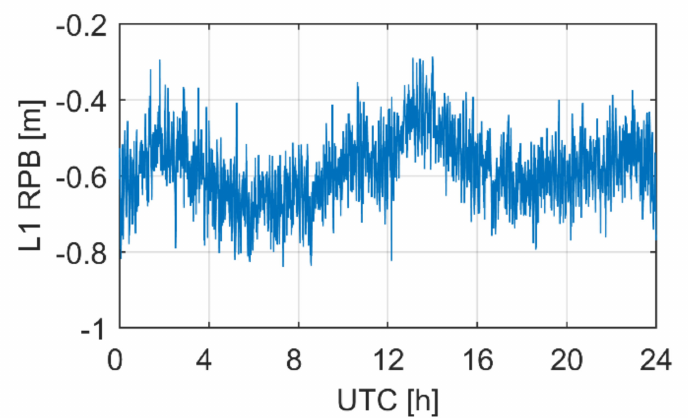
Figure 3. Time series of the GPS L1 RPB calculated using the IGG1–IGG2 baseline data collected on DOY 268, 2019.